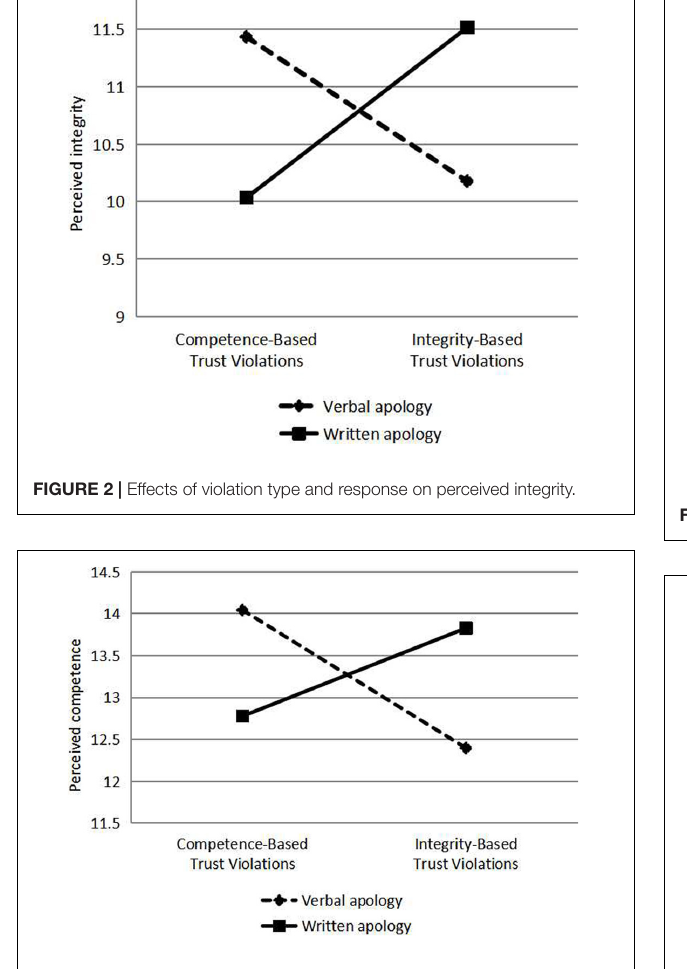
FIGURE 3 | The effects of violation type and response on perceived competence.